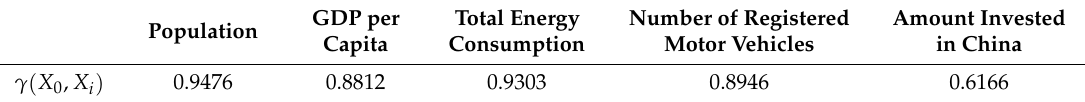
Table 7. Grey correlation of the amount of CO 2 emissions and factors.